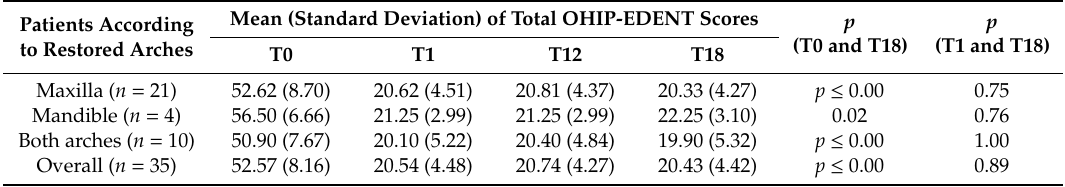
Table 4. Mean and standard deviation of total OHIP-EDENT scores post denture insertion (T0) and at 12 (T12) and 18 months (T18). Comparison between baseline and 18 months evaluation, respectively, 1 week follow-up and 18 months.